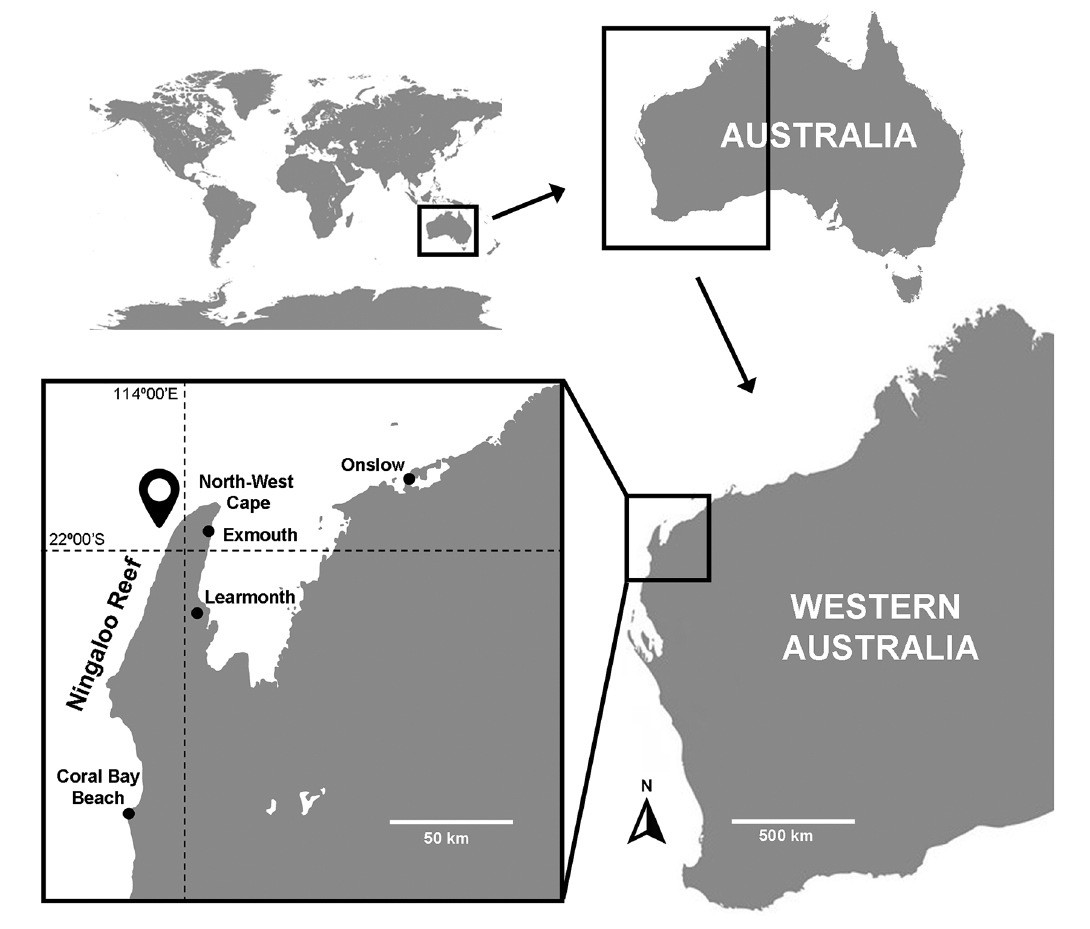
Figure 1. Map showing type locality of Parapseudaeginella australiensis n.